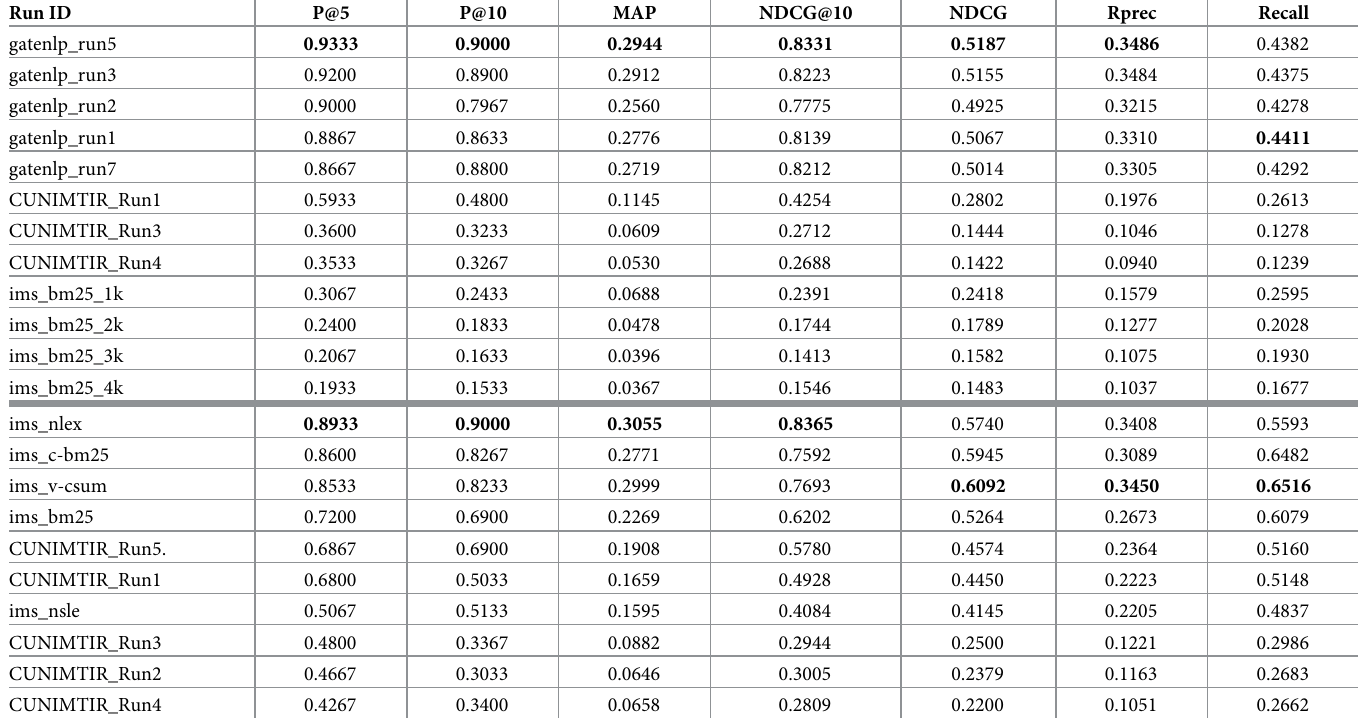
Table 3. Results for monolingual English runs. Our runs have gatenlp_ as a prefix in the name of the run. The first part of the table contains runs which retrieve 200 documents per query and the second part of the table contains runs which retrieve 1000 documents for each query. Best overall scores are highlighted in bold. Run